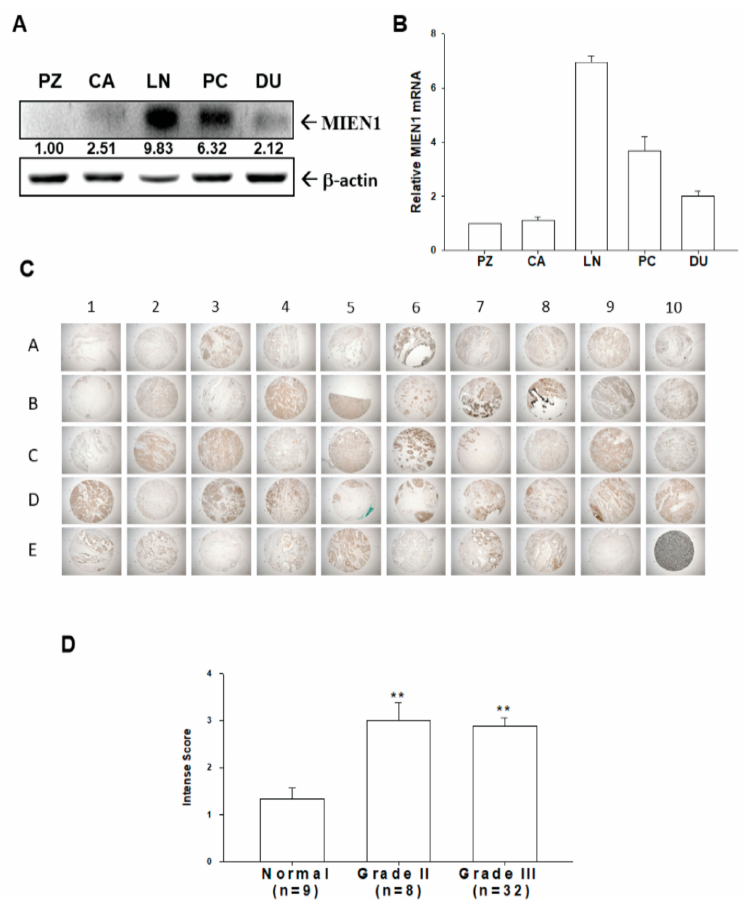
Figure 1. Expression of migration and invasion enhancer 1 (MIEN1) in human prostate carcinoma cells and prostate tissues. The expression levels of MIEN1 in prostate carcinoma cells (PZ: PZ-HPV-7; CA: CA-HPV-10; LN: LNCaP; PC: PC-3; DU: DU145) were determined by ( A ) immunoblotting and ( B ) RT-qPCR. The number indicates the ratio of MIEN1 / β -Actin in relation to PZ-HPV-7 cells. ( C ) Immunohistochemical staining for MIEN1 in a human prostate tissue array with normal and prostate cancer tissues (grades II and III). ( D ) The intense scores of MIEN1 immunostaining in normal ( n = 9) or prostate cancer tissues (grade II, n = 8; grade III, n = 32). ** p < 0.01. 2.2. MIEN1 Is the Downstream Gene of NF-kB Signaling and Induces Akt Phosphorylation in Prostate Carcinoma